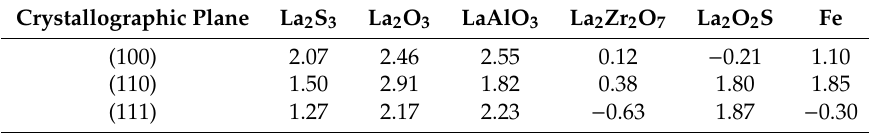
Table 5. Fermi energies of inclusions and the Fe matrix at three di ff erent low-indexed crystallographic planes (eV).